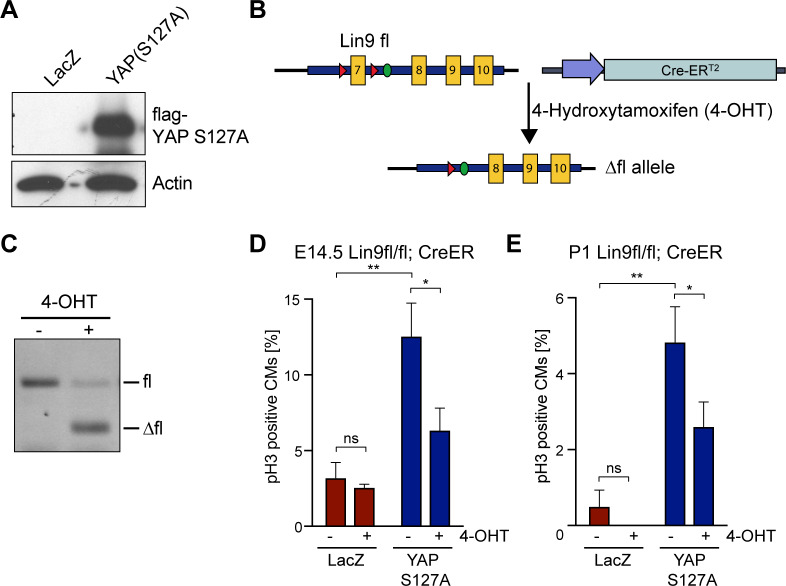
Cardiomyocyte proliferation by activated YAP requires MMB.A) Cardiomyocytes isolated from neonatal (P1) Lin9fl/fl; CreERT2 mice were transduced with a LacZ control (Ade-LacZ) or FLAG-YAP(S127A) expressing adenovirus. Expression of YAPS127A was verified by immunoblotting with a flag-antibody 72 hours after adenoviral transduction. Actin served as a control. B) Scheme of the floxed Lin9 locus and the CreERT2 transgene. After addition of 4-OHT, CreERT2 is activated to delete the floxed exon 7 of Lin9 [37]. Lox sites are indicated by red triangles. C) Cardiomyocytes isolated from Lin9fl/fl; CreERT2 hearts were treated without and with 4-OHT as indicated and the deletion of Lin9 was verified by genomic PCR. D) and E) Embryonal (E14.5) Lin9fl/fl; CreERT2 cardiomyocytes (D) or postnatal (P1) cardiomyocytes (E) were transduced with Ade-LacZ or with Ade-YAP[S127A] and treated with or without 4-OHT. The fraction of pH3-positive cardiomyocytes was quantified. Example microphotographs are shown in S4 Fig. Error bars show SDs of biological replicates (n = 3).